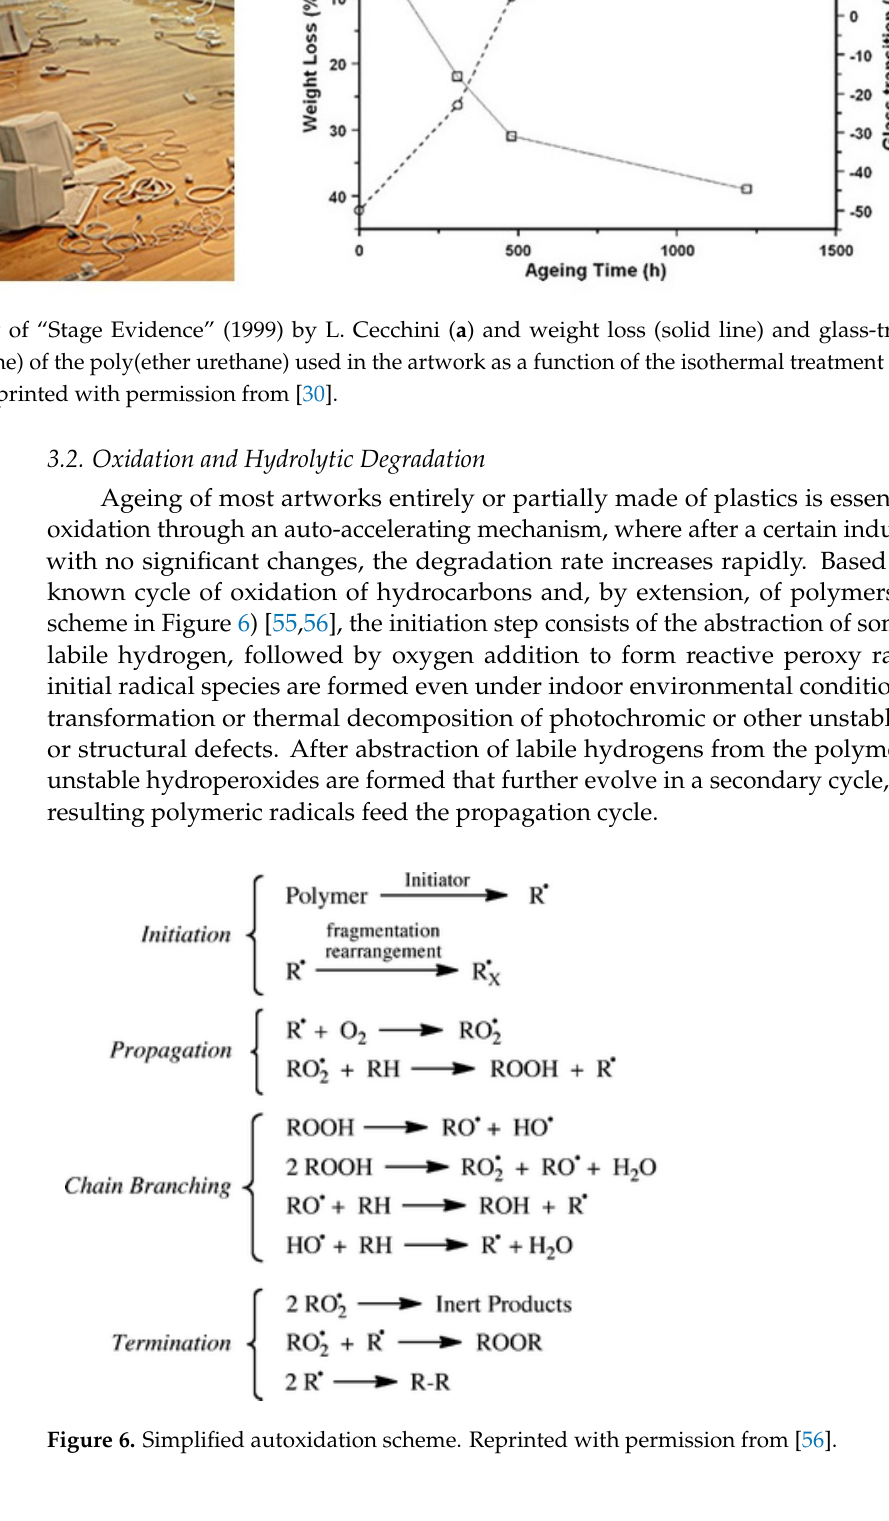
10 of 25 Figure 4. ATR-FTIR spectra measured for cleaned 30-year-old PVC at different durations (in weeks) of artificial thermal ageing ( a ) and evolution of the advancing contact angle as a function of the artificial ageing time for an as-collected ( ○ ) and a cleaned ( ● ) 30-year-old PVC film in an open environment ( b ). Image reprinted with permission from [54]. Although further studies are necessary to extend the conclusions to other plasticised polymers, the study by Royaux et al. concludes that, at least for PVC, an efficient preser- vation strategy may pursue a longer conservation of properties, including visual appear- ance, while maintaining the artefacts in closed containers. The results also provide crucial information on applying treatments, removing additive surface accumulation to improve their visual aspect without any subsequent degradation. Another example of migration of plasticisers in contemporary artworks has been re- vealed in an installation by L. Cecchini, composed of many rubber objects. GC/MS identi- fied the yellowish sticky liquid exuded from their surface as a mixture of phthalates con-